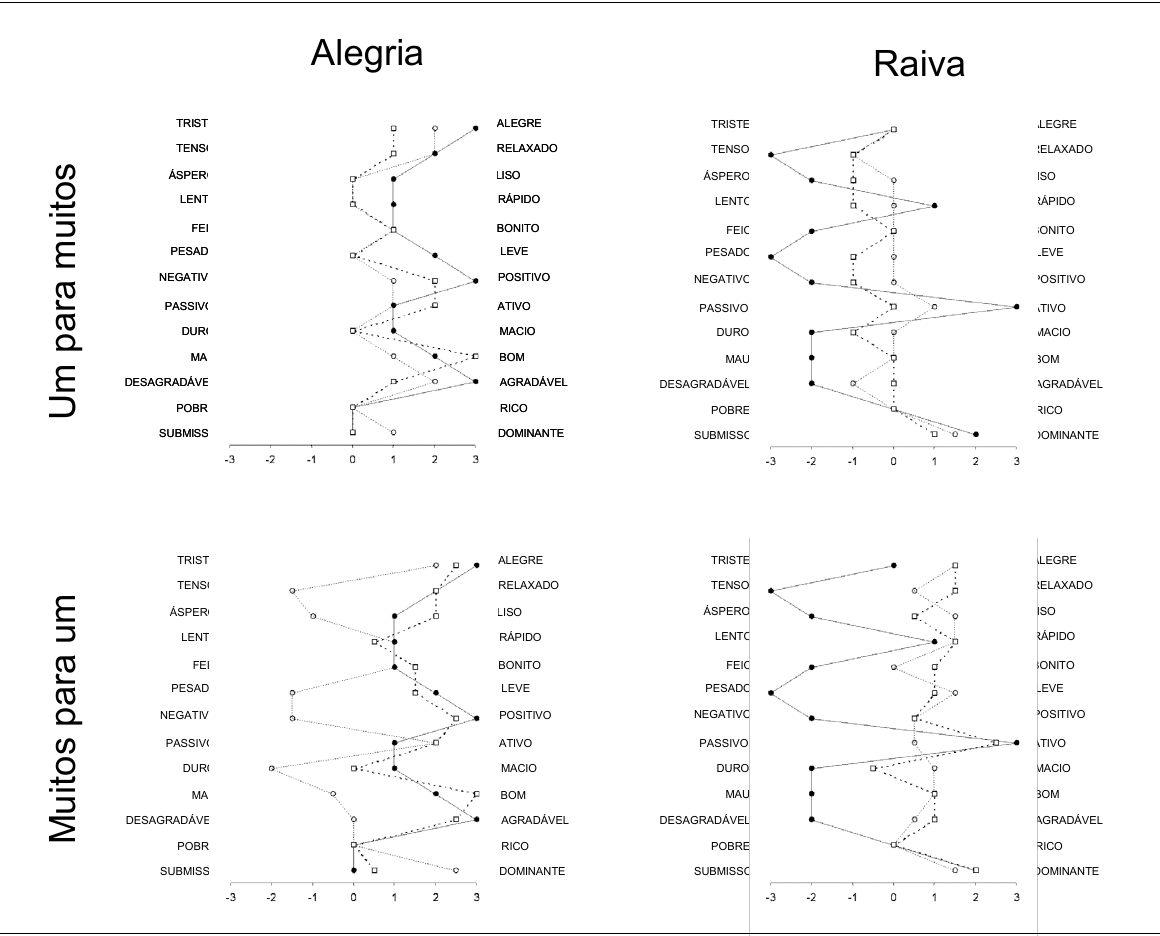
Figura 4 . Medianas das avaliações das faces alegres e raivosas feitas pelos participantes do grupo controle (linhas contínuas) e dos estímulos D e E (linhas tracejadas) feitas pelos dois grupos